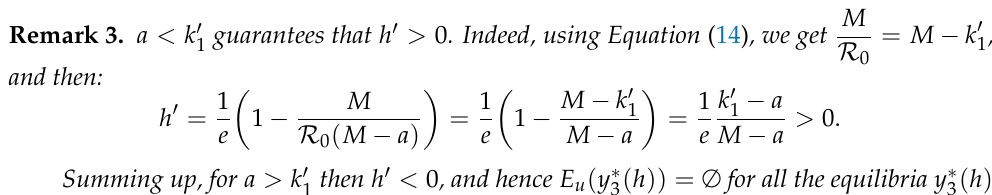
= 8 and σ 0 = − 6, N C